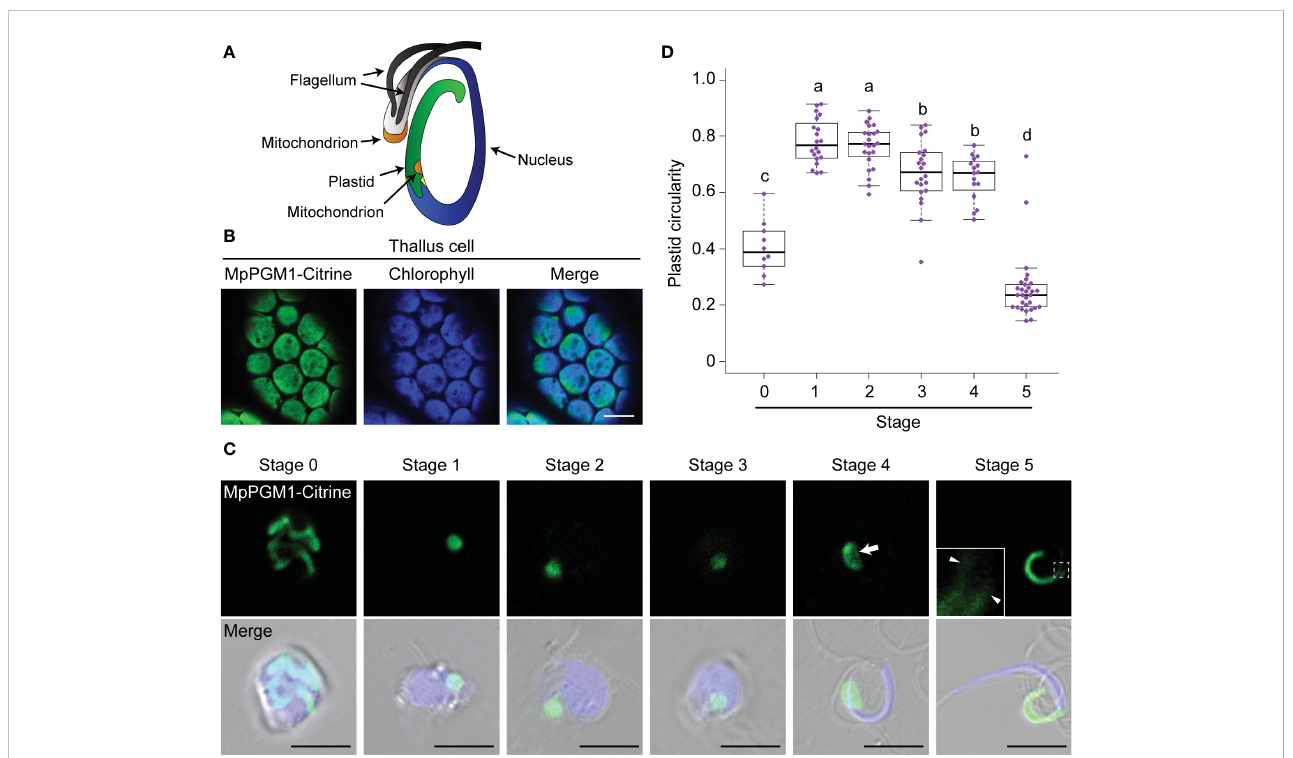
FIGURE 1 Morphological changes of the plastid during spermiogenesis in M. polymorpha . (A) Schematic illustration of a spermatozoid of M. polymorpha , depicted based on Carothers (1975). (B) Confocal images of thallus cells expressing MpPGM1-Citrine (green). The auto fl uorescence from chlorophyll is shown in blue. Eighteen cells were observed, and a representative result is presented. Scale bar = 10 m m. (C) Maximum-intensity projection images of cell-wall- digested antheridial cells and a spermatozoid at each developmental stage expressing MpPGM1-Citrine (green). A total of 20 stage-0, 29 stage-1, 32 stage-2, 31 stage-3, 22 stage-4, and 32 stage-5 cells were observed; representative images are presented. The nuclei were stained with Hoechst 33342 (blue). The arrow and arrowhead indicate the region of the weak signal from MpPGM1-Citrine and tubular extension from the plastid body, respectively. Scale bars = 5 m m. (D) The circularity of the plastid was calculated using the same set of samples analyzed in (C) . The boxes and solid lines in the boxes indicate the fi rst and third quartiles and the median, respectively. The upper and lower whiskers are drawn at the greatest value smaller than 1.5× the interquartile range (IQR) above the third quartile and the smallest value greater than 1.5× the IQR below the fi rst quartile, respectively. Different letters denote signi fi cant differences based on the Steel – Dwass test ( p <